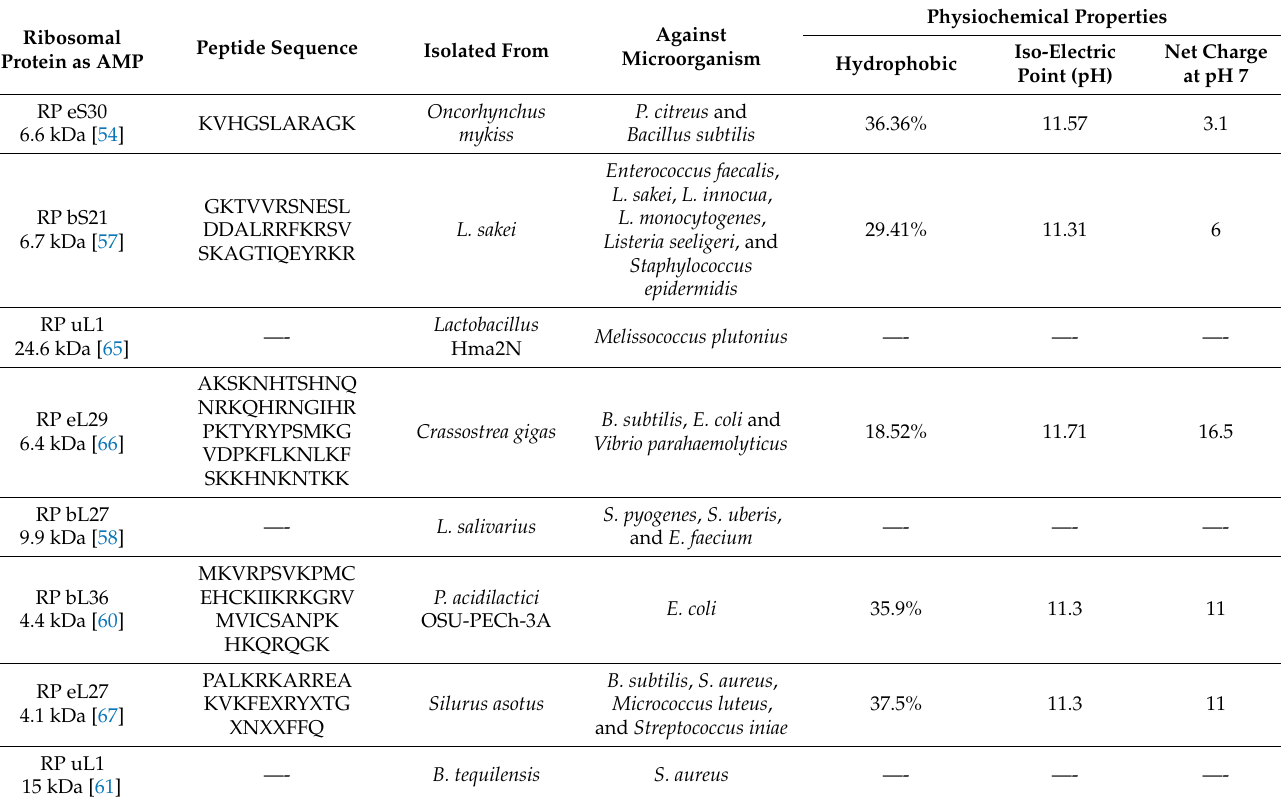
Table 4. Different ribosomal proteins as AMPs isolated from